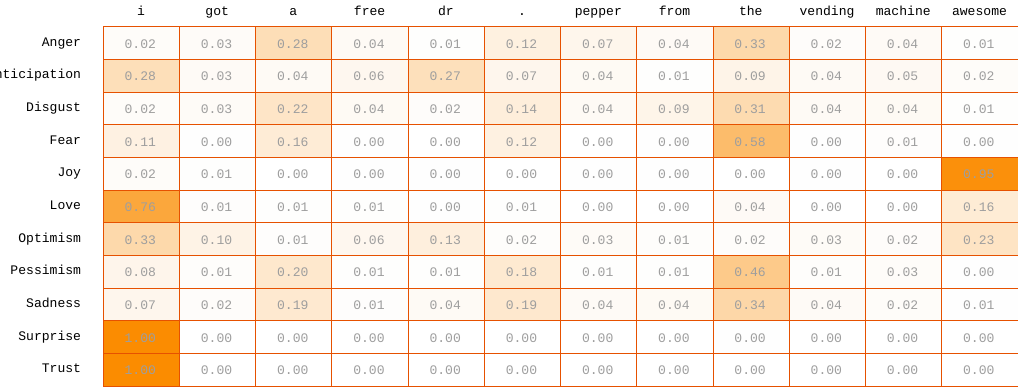
Figure 6. Attention visualization example. Golden labels are { joy , surprise } and predicted labels are { joy (0.97) , optimism (0.87) }. 2/14/2019